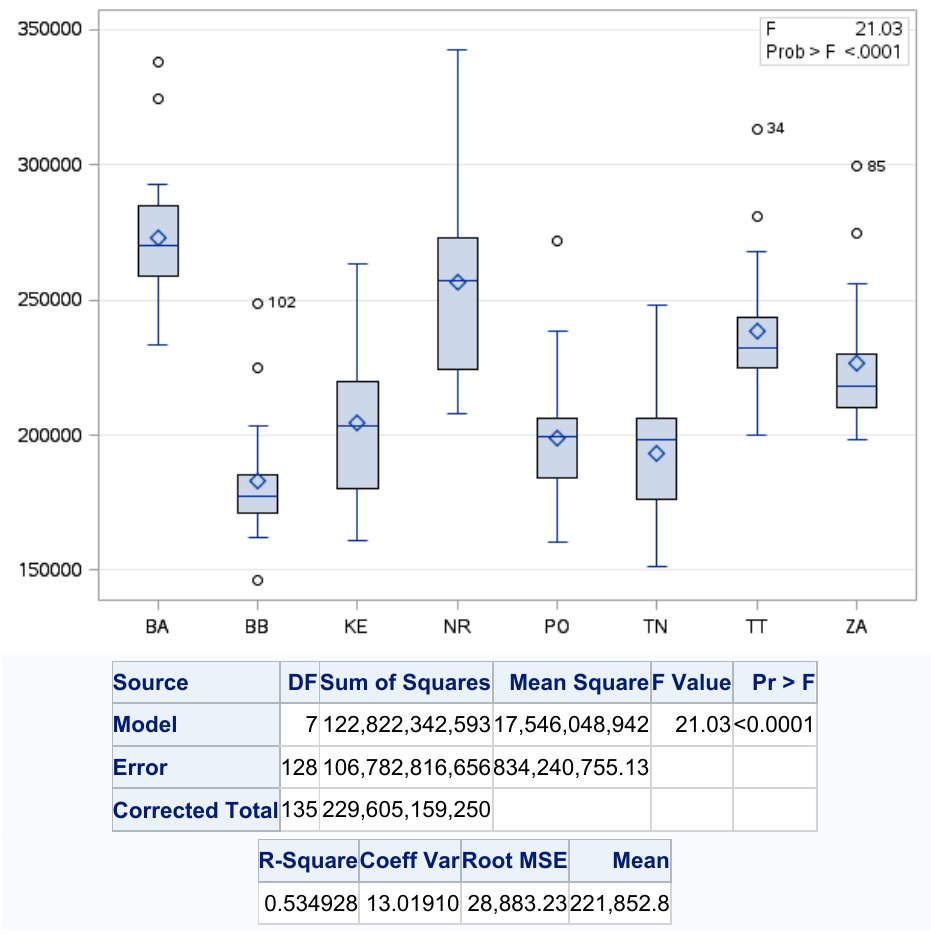
Figure 3. One-factor analysis of municipal waste production in the regions of Slovakia. Source: Based on of data collected by Statistical Office of Slovak Republic [29].